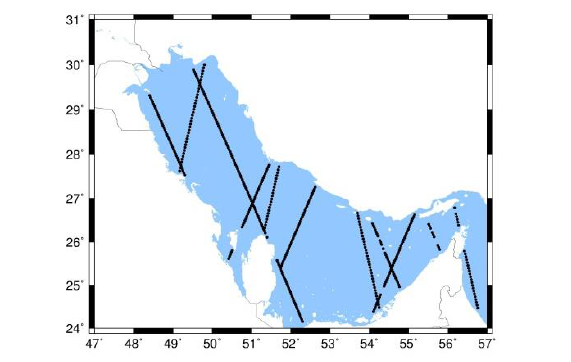
Figure 3. altimetry tracks in 26 until 30 Dec